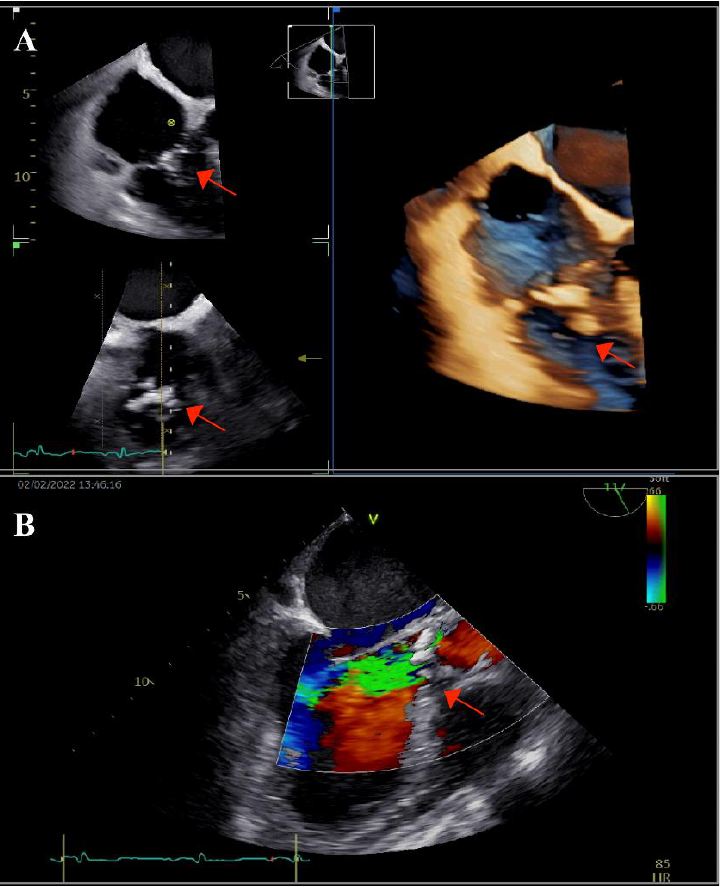
Figure 1. Transesophageal echocardiography: ( A ) bi- and tri-dimensional acquisitions depicting multiple vegetations on the tricuspid valve (arrow) and ( B ) long-axis view showing the aortic valve with vegetations (arrow) and the severe aortic regurgitation. The left aortic coronary cusp was perforated, which was later confirmed during surgery.